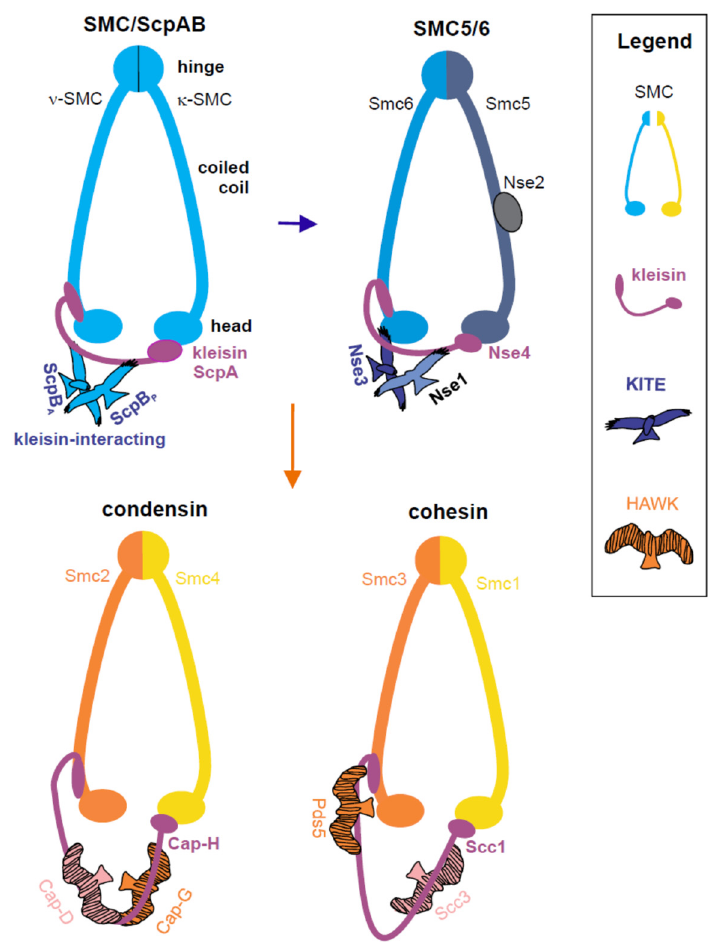
Figure 1. The structural maintenance of chromosome (SMC) complexes form rings. The long coiled-coil SMC proteins interact via their hinge domains at one pole and their heads are bridged at the other pole by the kleisin protein (violet; kleisin’s N- and C-terminal domains bind different SMC proteins). There are two types of kleisin-interacting subunits in different SMC complexes. In the prokaryotic SMC/ ScpAB (segregation and condensation protein) and eukaryotic SMC5/6 complexes, the kleisin molecules bind to the kleisin-interacting tandem winged-helix element (Kite) proteins (suggesting an evolutionary path from prokaryotes to eukaryotes via an ancestral SMC5/6-like complex; blue arrow). In the eukaryotic condensin and cohesin complexes, kleisins interact with the HEAT proteins associated with kleisin (Hawk) proteins (suggesting their later evolution; orange arrow). In addition, the SMC5/6 complex contains a unique conserved Nse2 subunit attached to the SMC5 coiled-coil arm, which possesses small ubiquitin-like modifier (SUMO)-ligase activity. The non-conserved Nse5 and Nse6 subunits are omitted for simplicity.